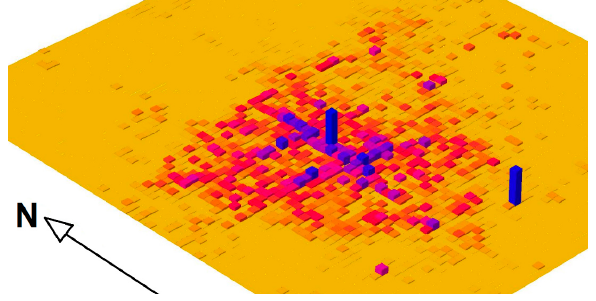
Table 1. Specifications of the data logger installation point.